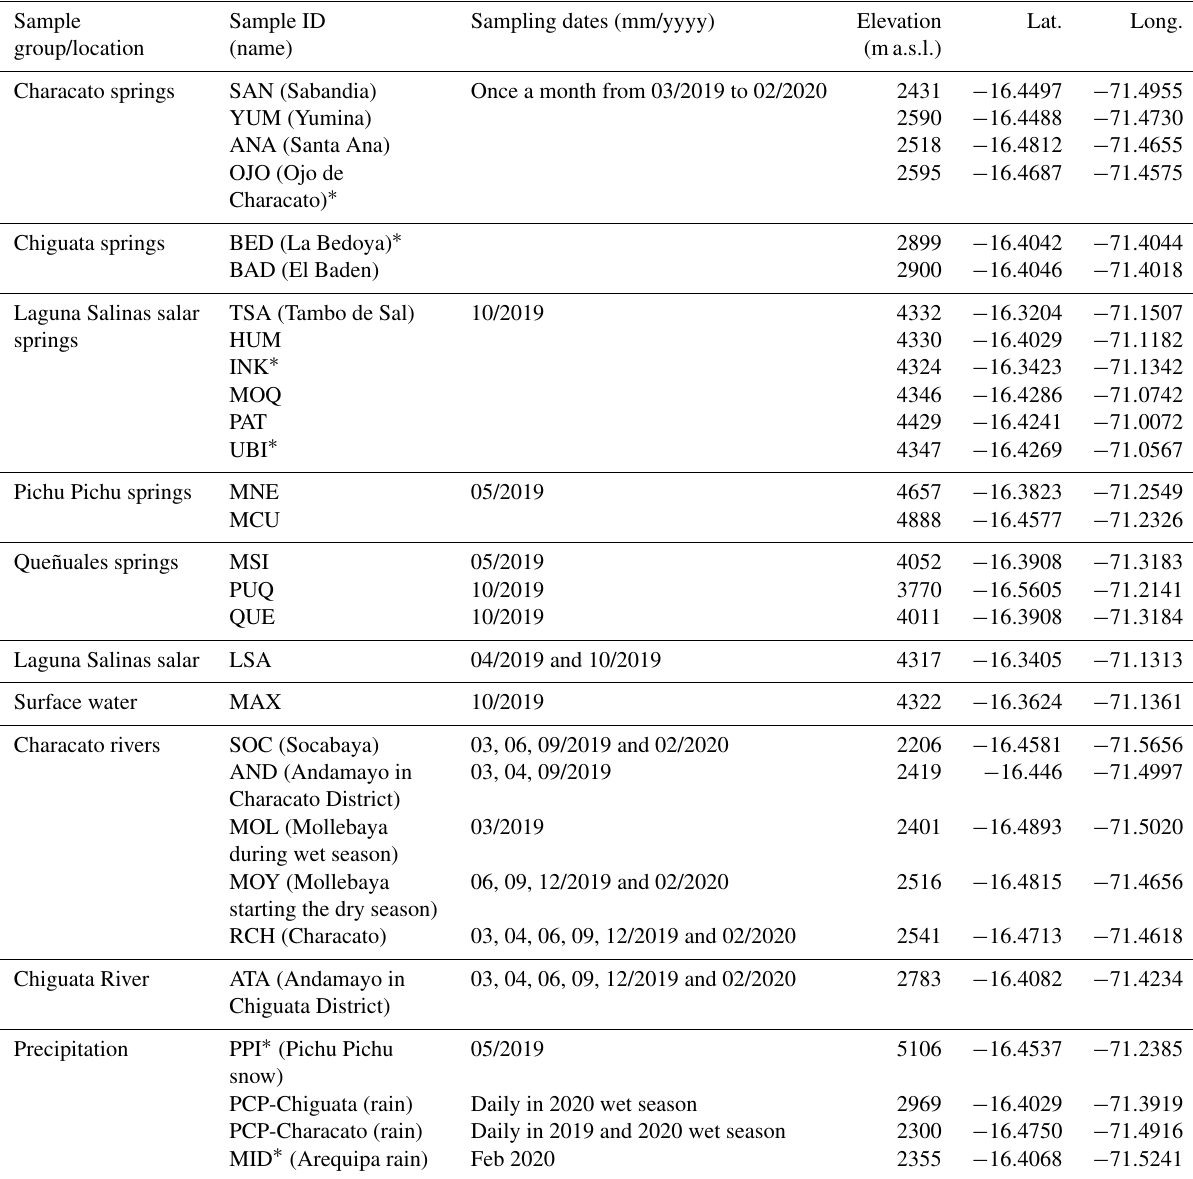
∗ Indicates this site was analyzed for 3 H . Note: PCP refers to